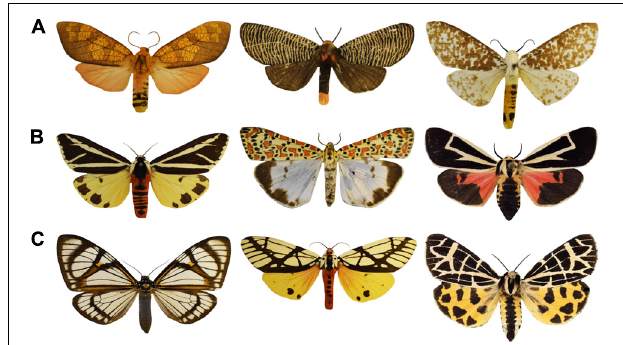
FIGURE 3 | Varieties of detailed elements found in arctiid dorsal forewing patterns. Detailed pattern elements often appear in conjunction with the homologous pattern elements, similar to what has been documented in the butterflies. Animals shown in row (A) exhibit disruptive details, which include Turing-like patterns that serve as background coloration, and stochastic melanization that is overlaid on top of the primary pattern elements (left: Elysius conspersus ; middle: Graphelysia strigilcata ; right: Spilosoma aspersa ). Animals depicted in row (B) possess dorsal forewing patterns that include filled wing cells. This detailed feature occurs when an intervenous region such as the discal cell becomes completely pigmented, creating a structure that closely outlines the focal venous compartment (left: Areas imperialis ; middle: Utetheisa pulchella ; right: Apantesis nais ). The specimens shown in row (C) exhibit venous striping, which partially or completely outlines the wing’s veins (left: Eucyane phanoptoides ; middle: Pericallia obliquifascia ; right: Apantesis ornata